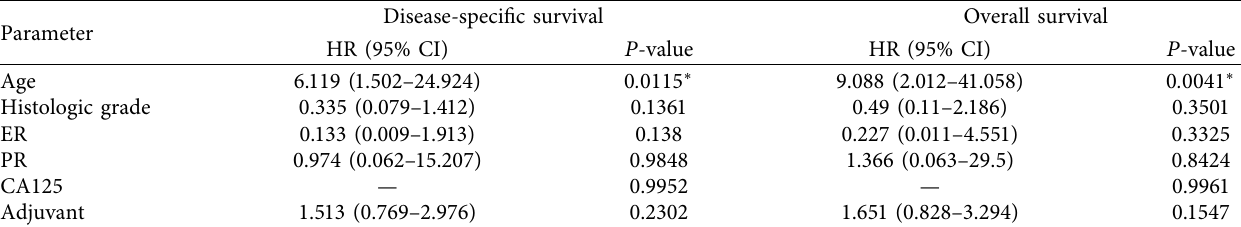
Table 3: Multivariate analysis of risk factors afecting the disease-specifc survival and overall survival status in women with stage I endometrial